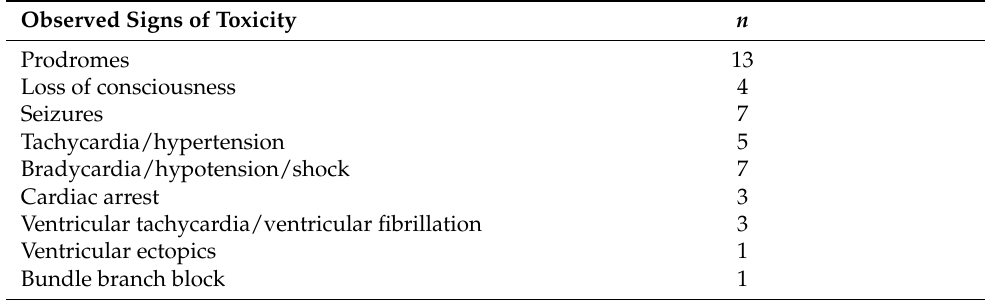
Table 2. Observed signs and symptoms of CNS and cardiovascular toxicity ( n = 33 patients).